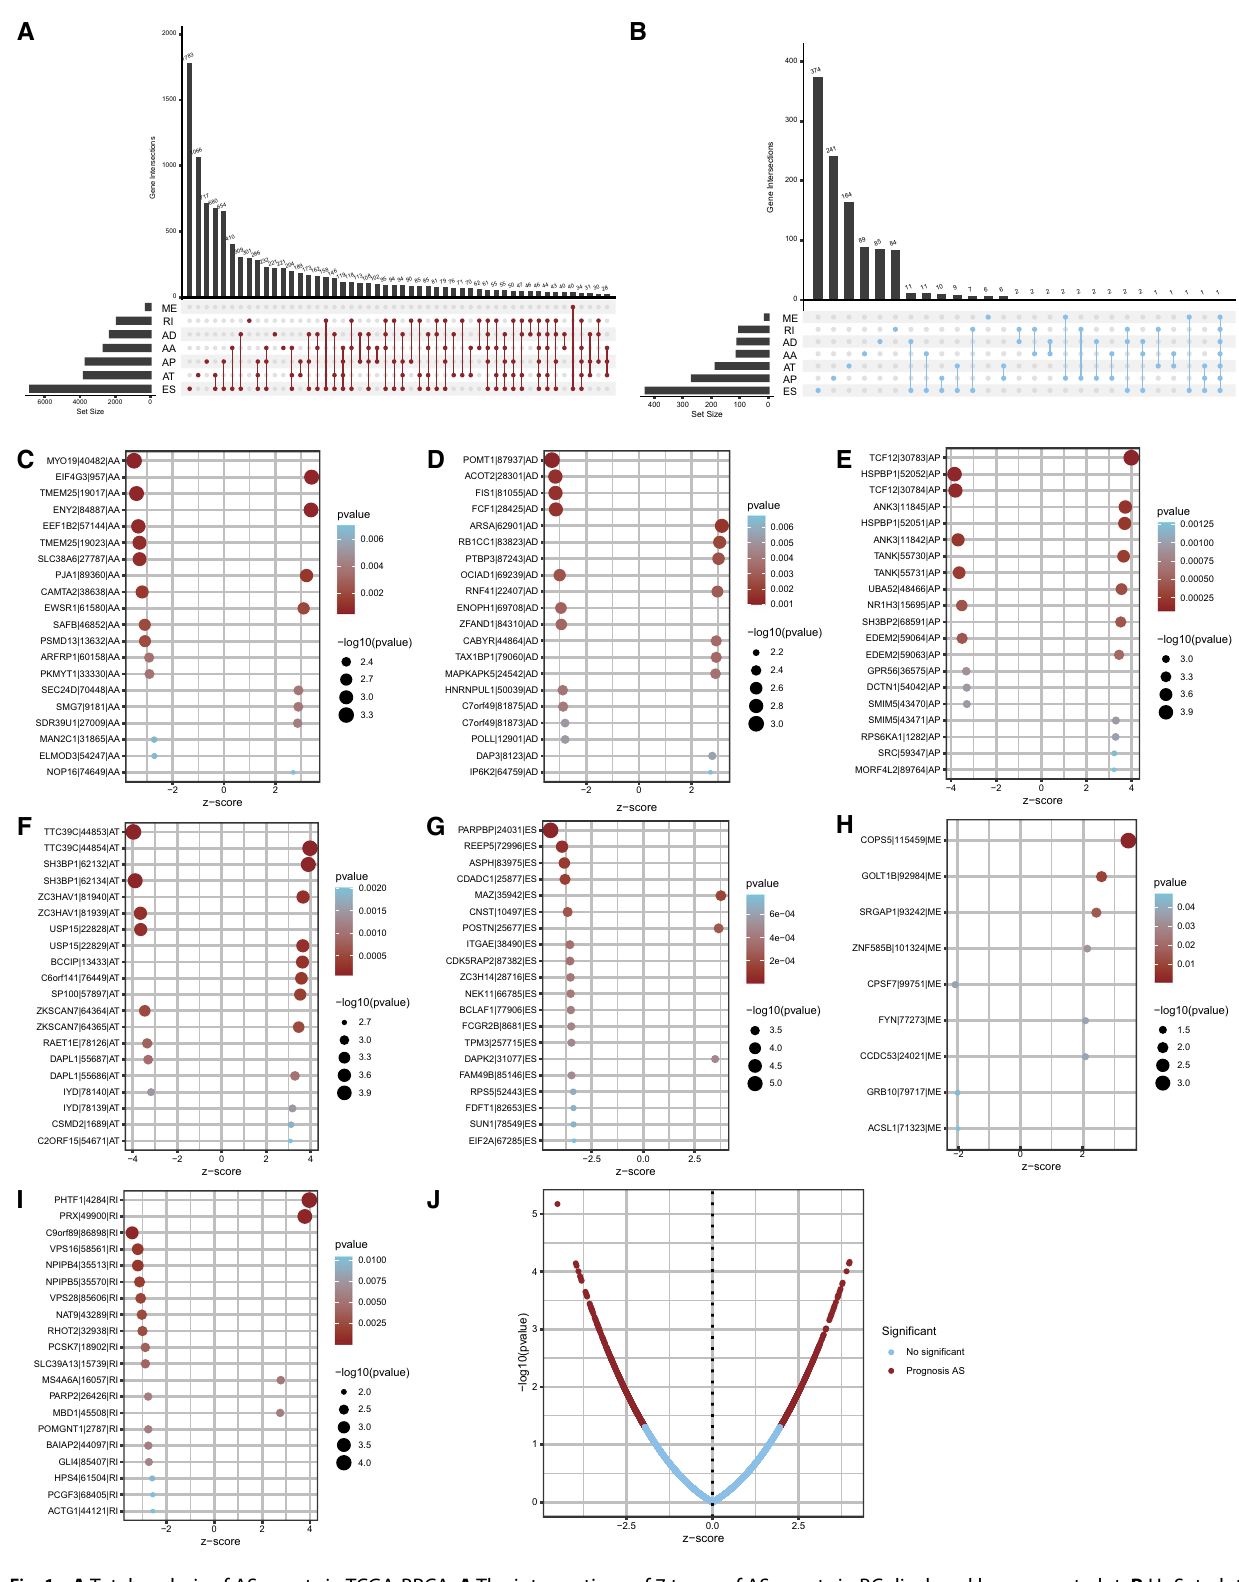
Fig. 1 A Total analysis of AS events in TCGA-BRCA. A The intersections of 7 types of AS events in BC displayed by an upset plot; B UpSet plot of the intersections of 7 types of AS events significantly associated with survival in BC filtered by univariate Cox regression analysis (p < 0.05); C – I bubble plots of the AS events significantly associated with survival in BC; J the strength of association between AS events and BC shown by volcanic